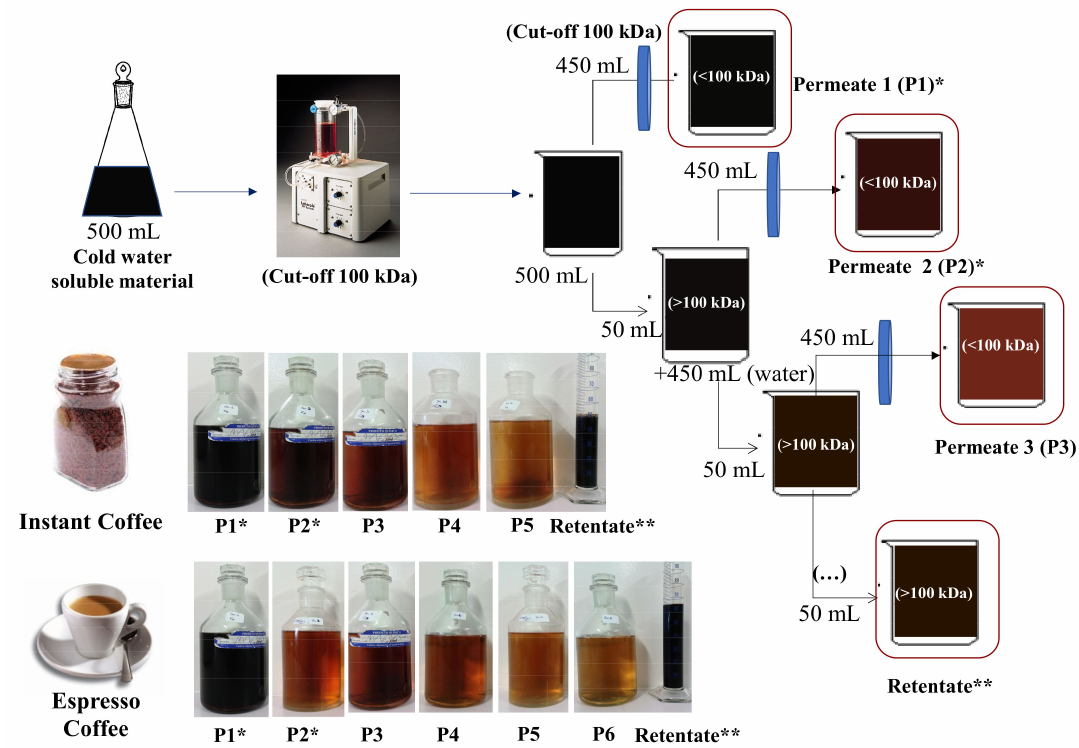
Figure 1. Schematic representation of the ultrafiltration process with photos of the successive Permeates and Retentate for espresso coffee and instant coffee brews. * Permeates 1 and 2 represent the most abundant fractions of Low Molecular Weight (LMW) compounds. ** Retentate represents the fraction of High Molecular Weight (HMW)